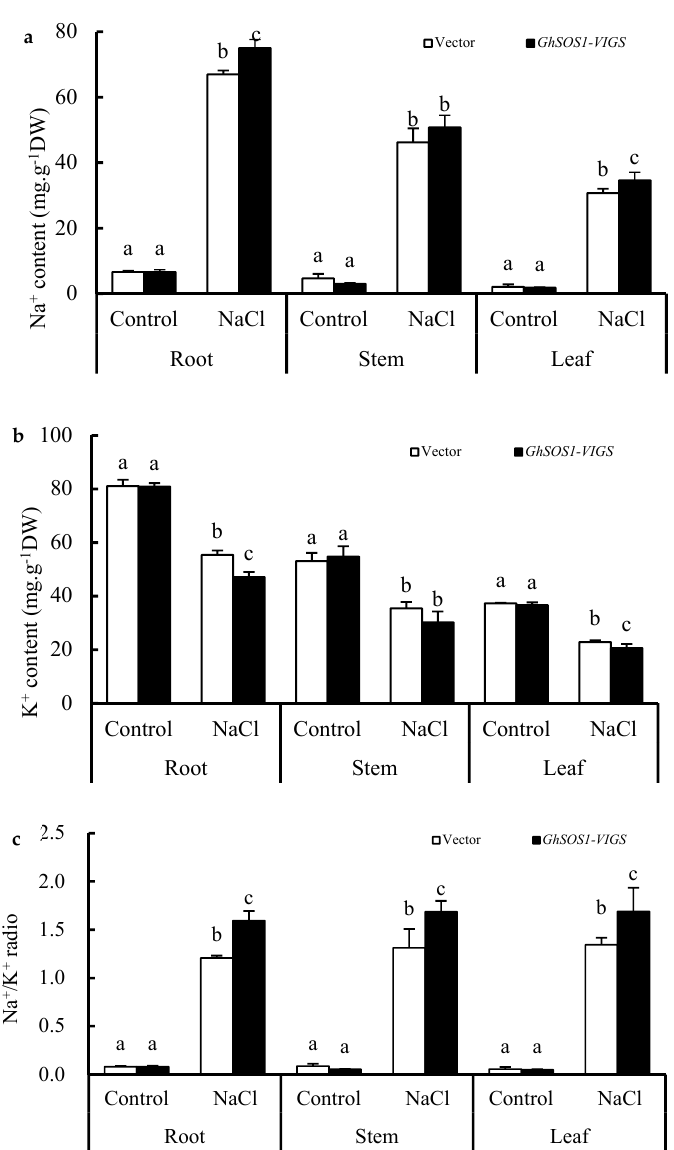
Figure 2. Changes in contents of Na + ( a ) and K + ( b ), and Na + /K + ratio ( c ) in the roots, stems, and leaves of the GhSOS1 -VIGS cotton plants under salt stress. Different lowercases in the same group indicate the significant differences ( p ≤ 0.05).